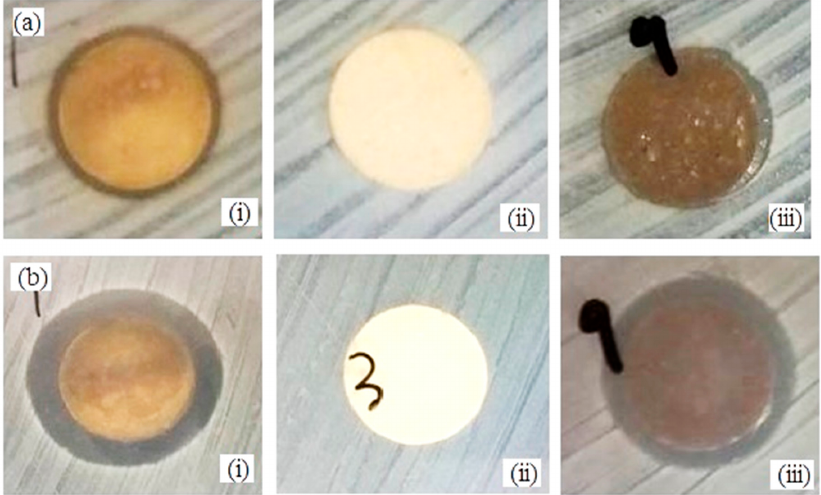
Figure 9. Antimicrobial activity by disc diffusion test of (i) Ag (control sample), (ii) β W and (iii) β WMAF disc for ( a ) E.coli and ( b ) S. aureus .